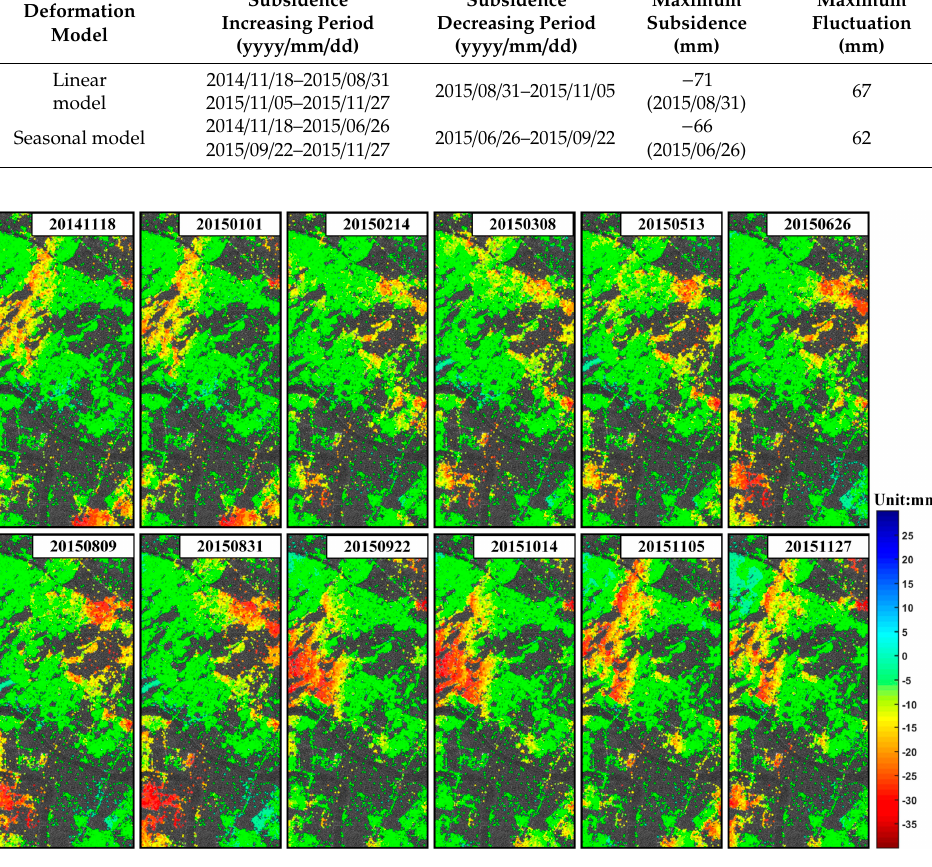
Figure 6. Time series deformation of Lungui Highway based on the linear model (referenced to 27 October 2014).